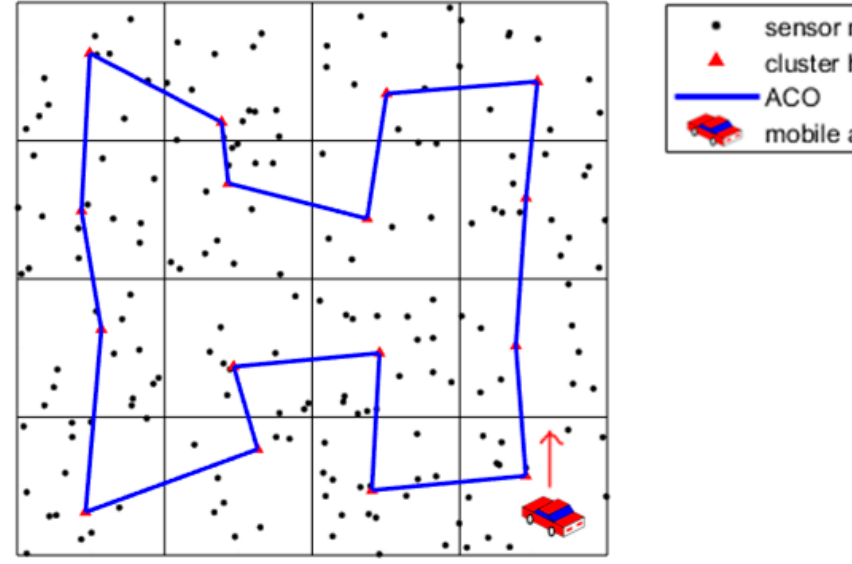
Figure 6. Shortest path selection using the ACO algorithm. The pseudocode of the ACO-based shortest path selection is described in Algorithm